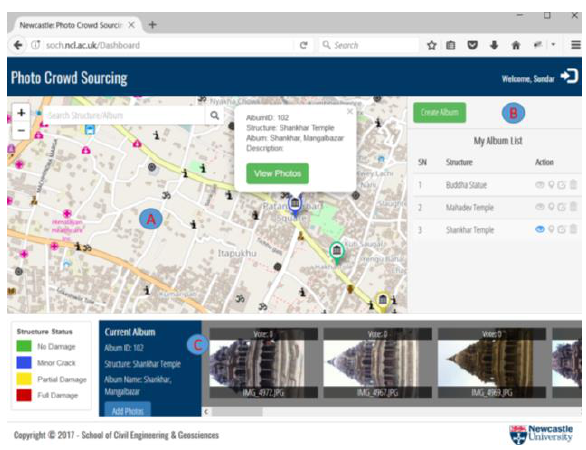
Figure 5. Web interface for crowdsourcing and visualisation